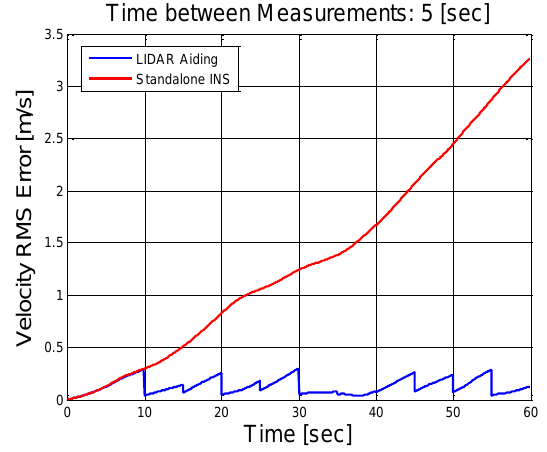
Figure 3: Velocity error for lidar aiding versus standalone INS.